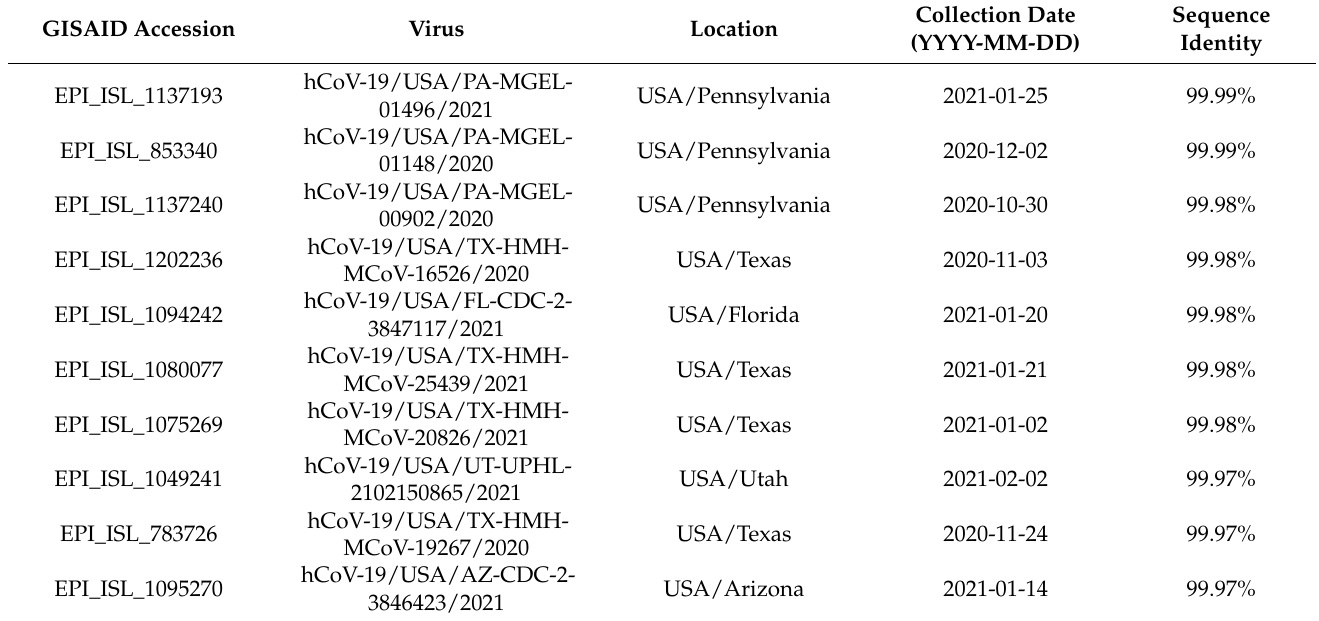
Table 2. SARS-CoV-2 sharing the highest nucleotide identity found by BLAST search in GISAID database on 14 March 2021. GISAID